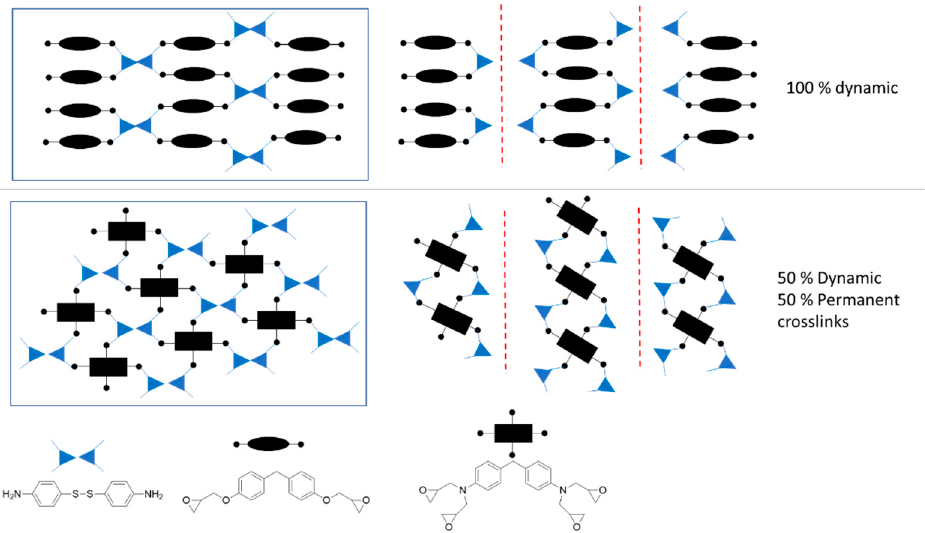
Figure 6. These conceptual schemes represent the dynamic and permanent crosslinks present in aero grade epoxy vitrimer. To simplify, networks with 100% difunctional epoxy monomer (100% dynamic crosslinks) and with 100% tetrafunctional epoxy monomer (50% dynamic crosslinks) are shown separately.